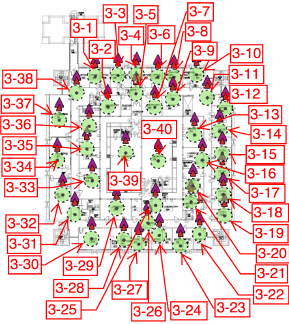
Figure 6. Distribution of AP on 3 rd floor of PSE